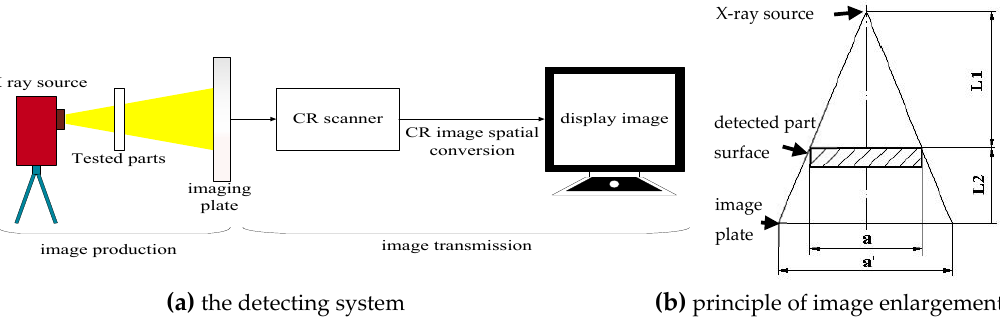
Figure 1. Schematic diagram of X-ray digital imaging detection.